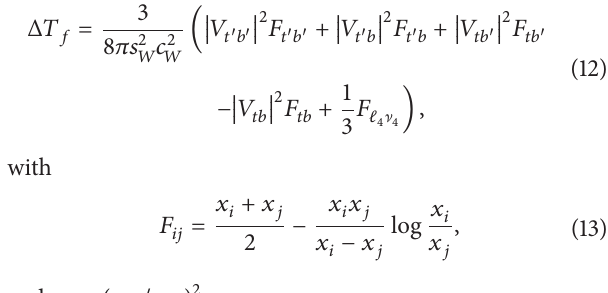
in the preivous section), since the 𝐻𝑓𝑓 Yukawa interactions of any 2HDM do not contribute at 1 loop to the gauge-bosons